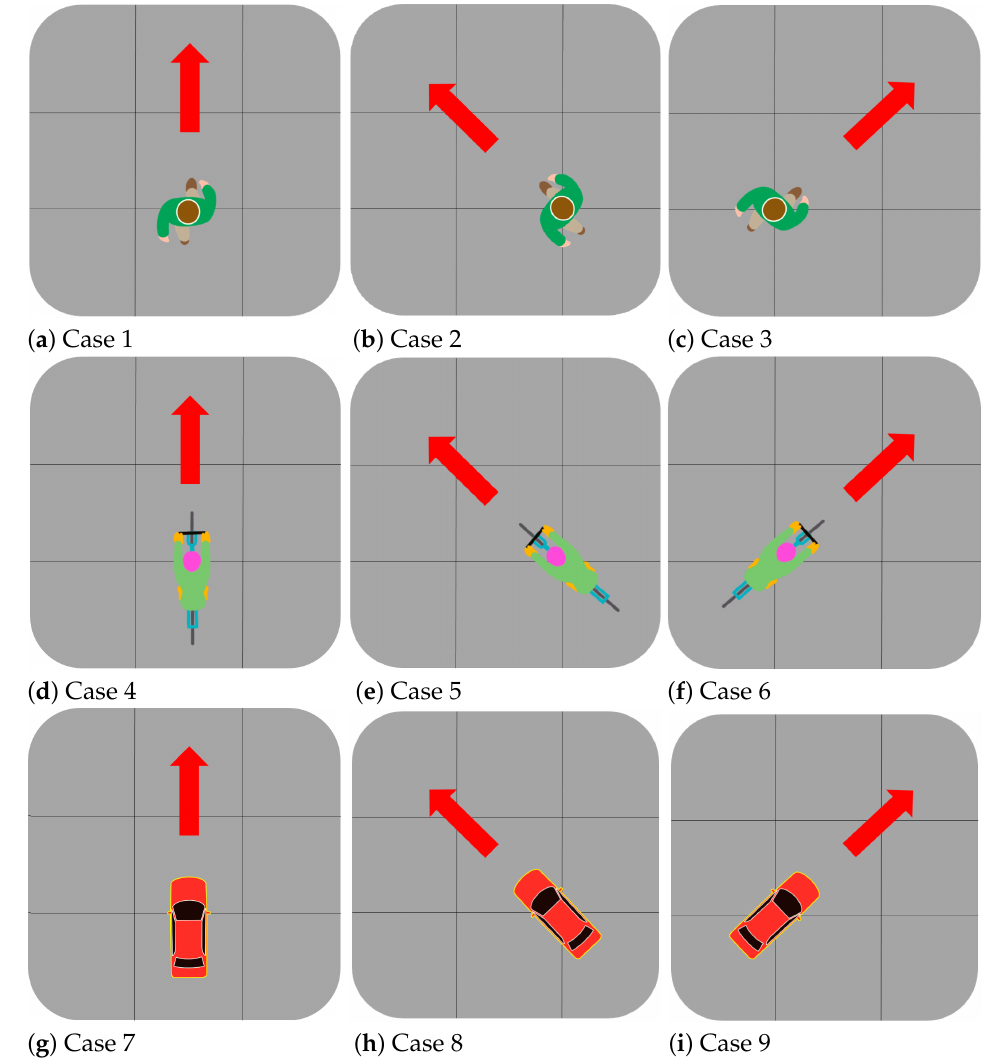
Figure 3. Experimental scenarios for a pedestrian, a cyclist, and a car: Cases 1 to